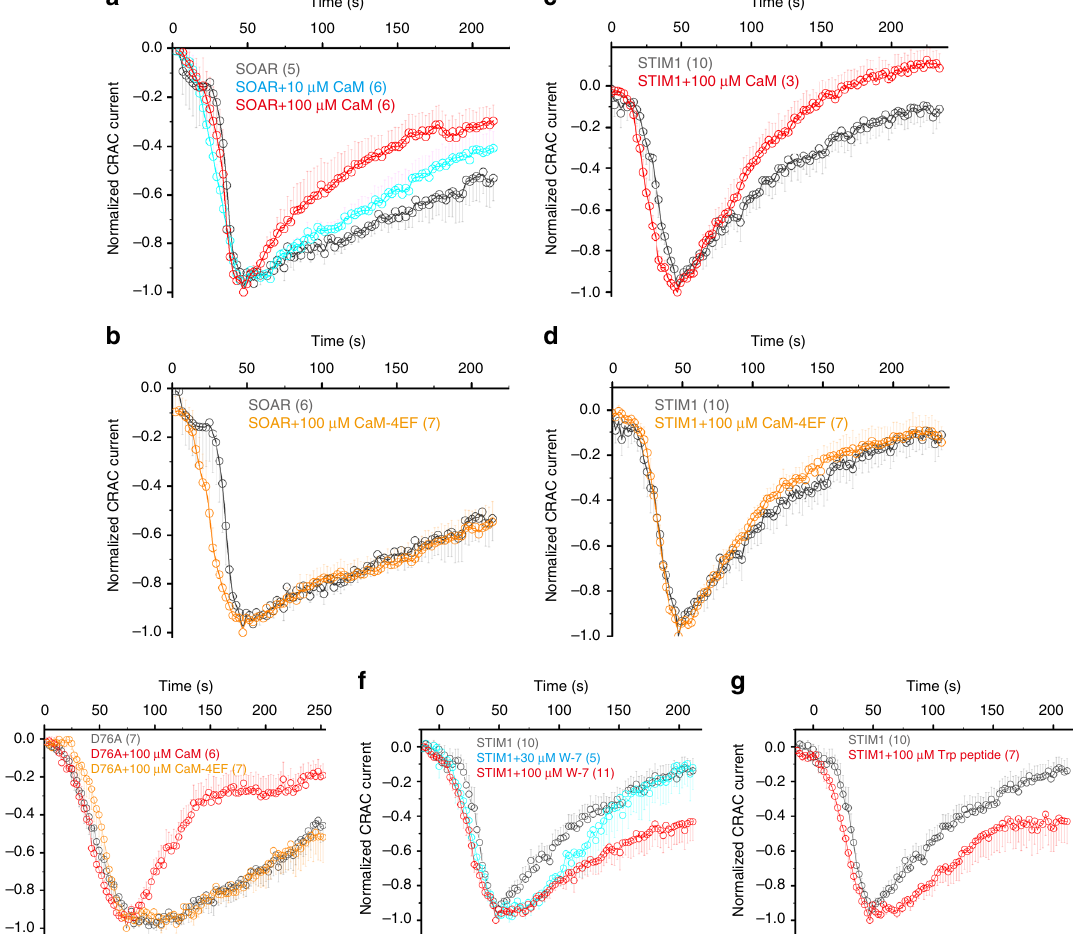
Fig. 2 Ca 2+ -CaM facilitates the SCDI of the Orai1 channel. Normalized averaged whole cell current at − 100 mV measured in HEK293 cells expressing Orai1 and SOAR a , b or expressing Orai1 and STIM1 c , d . CaM and CaM-4EF mutants were introduced to the pipette solution at the indicated concentration. e Normalized averaged whole cell current at − 100 mV measured in HEK293 cells that express Orai1 and the STIM1-D76A mutant alone, with CaM WT or with the CaM-4EF mutant at the indicated concentration. f , g Normalized averaged whole cell current at − 100 mV measured in HEK293 cells expressing Orai1 and STIM1 WT with inhibitors W-7 and the TRP peptide. W-7 and the TRP peptide were introduced into the pipette solution at the indicated concentration. For all current recordings, 2 mM extracellular Ca 2+ was slowly diffused to the cell surface using a perfusion system. The number in the parenthesis indicated the number of cells that were analyzed. Error bars denote